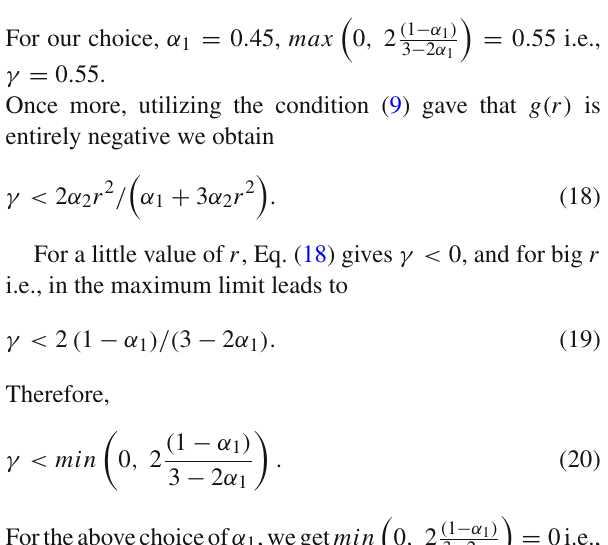
α α 1 0.45, 2 10 3 ,